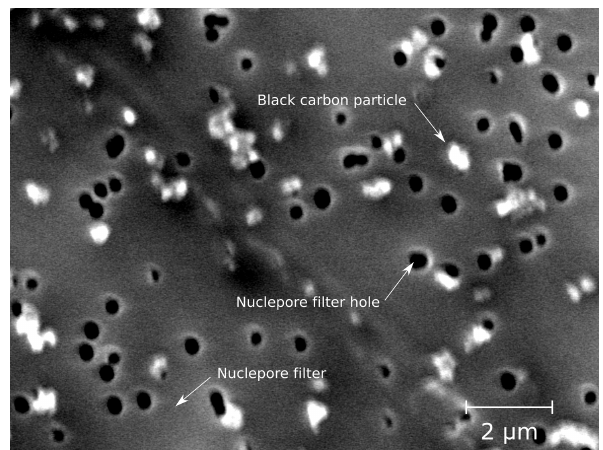
Figure 5. Scanning electron microscope image of gold coated black carbon particles (white) at a magnification of × 4000, showing a roughly spherical shape of the particles and an average particle di- ameter of 0.461 ± 0.331µm. Note that the image also shows the Nuclepore filter holes at 0.4µm